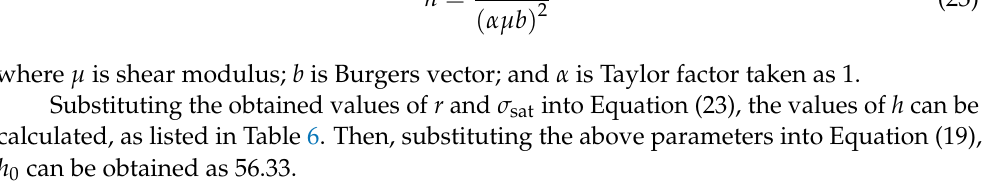
Table 6. Values of h under temperatures of 1123–1483 K and strain rates of 0.01–10 s − 1 . Temperature (K)